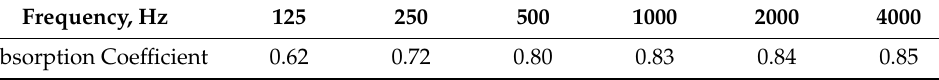
Figure 9. Lay-out of the absorbent materials, under lateral vaults.